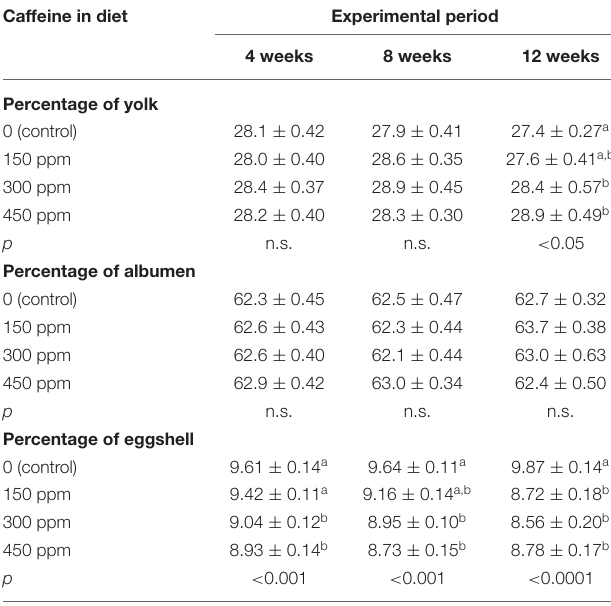
TABLE 6 | Percentages of yolk, albumen, and eggshell of the eggs produced by laying hens fed rations containing different concentrations of caffeine for 12 weeks. Caffeine in